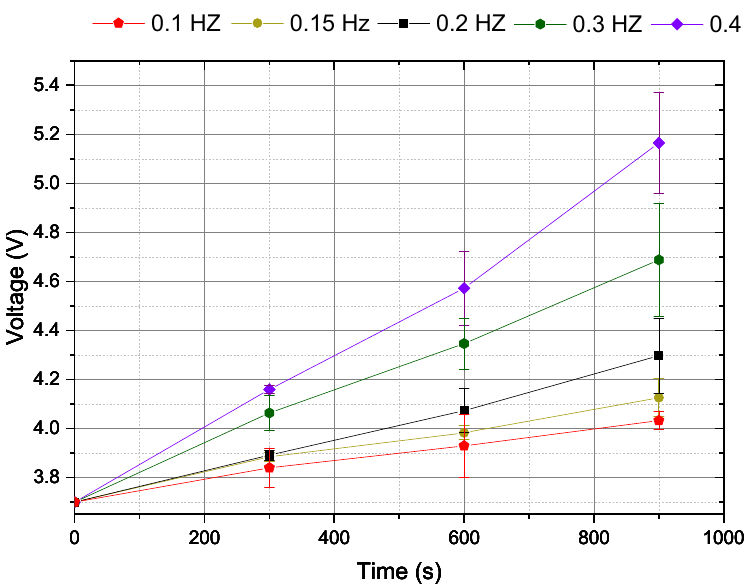
was measured in the total time of 900 s. Figure 14 shows the capacitor voltage measured at the initial time of 300, 600 and 900 s.